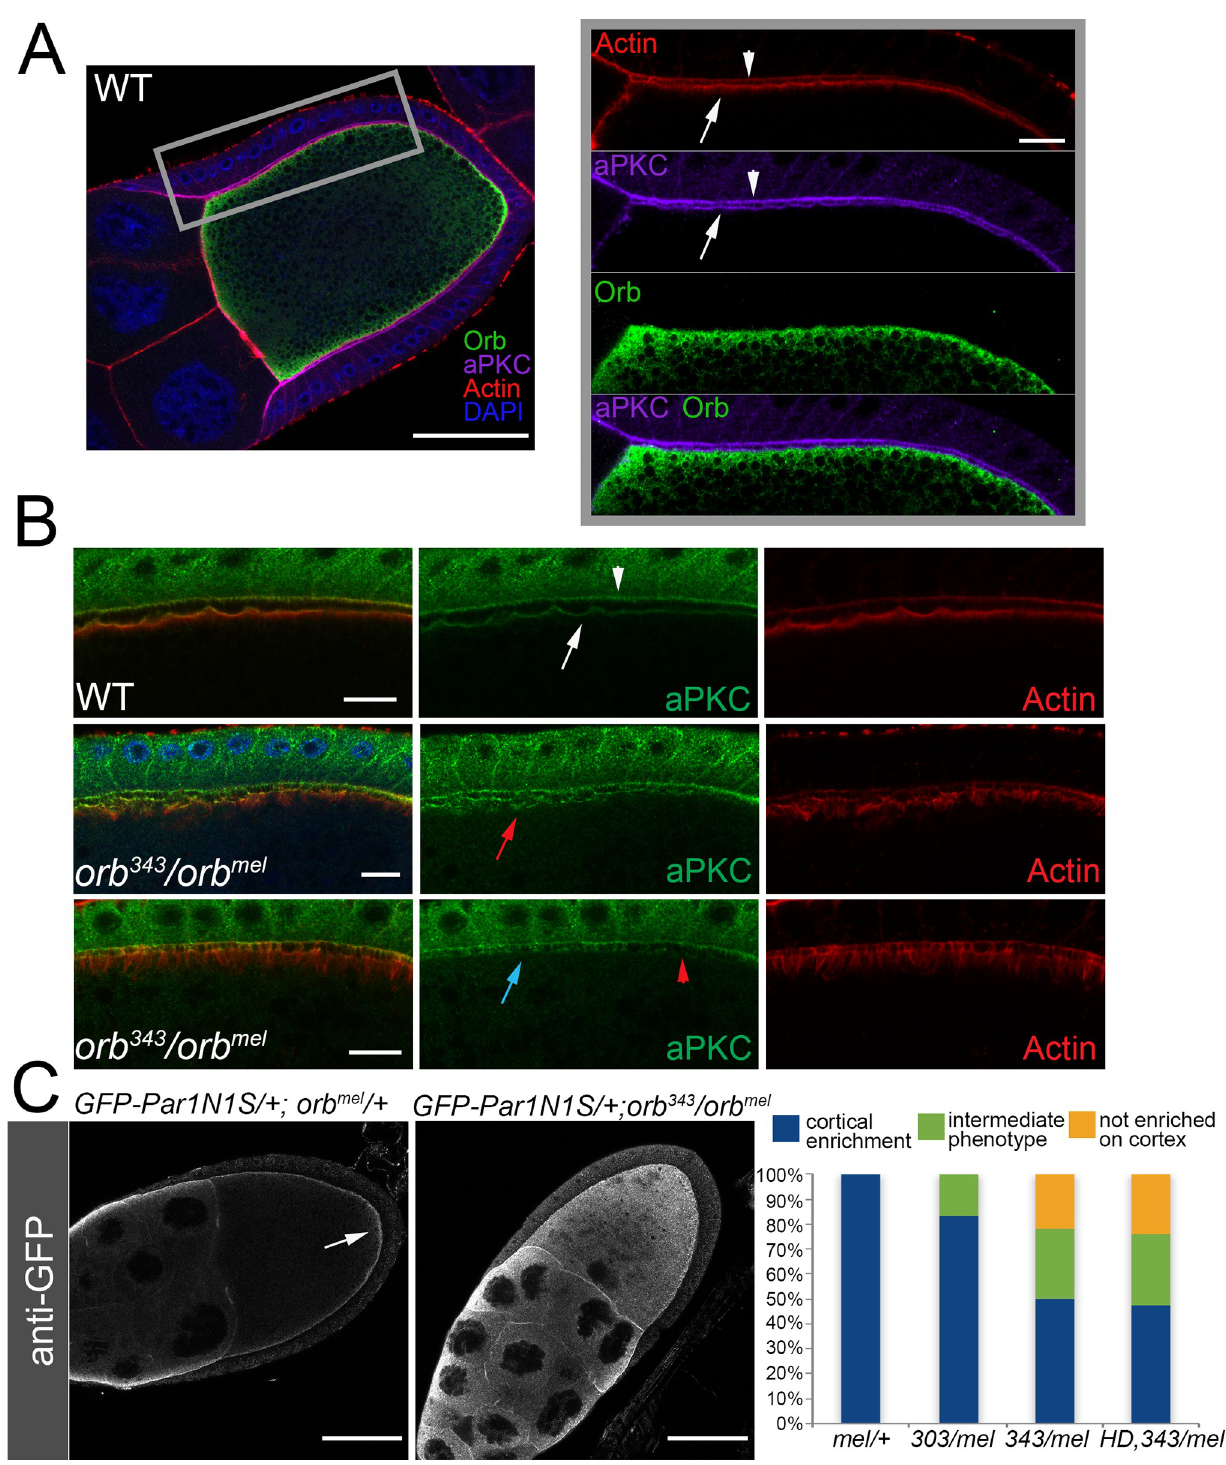
Fig 6. aPKC and Par-1 proteins are not correctly localized in orb mutants. (A) Left: A wild type stage 10 egg chamber stained with Orb (green), aPKC (magenta), Actin (red) and DAPI (blue). Scale bar 50 microns. Right: Zooming in on the lateral cortex demonstrates that Actin and aPKC co-localize at the apical domain of the follicle cells (arrowhead) and along the lateral cortex of the oocyte (arrow). Orb localization is subcortical and does not directly co-localize with aPKC or Actin on the cortex. Scale bar 10 mirons. (B) Top: In wild type aPKC protein is observed on the apical side of the follicle cells (arrowhead) and on the anterior lateral cortex of the oocyte (arrow) and colocalizes with actin in both tissues. Middle: In 343/mel the localization of aPKC